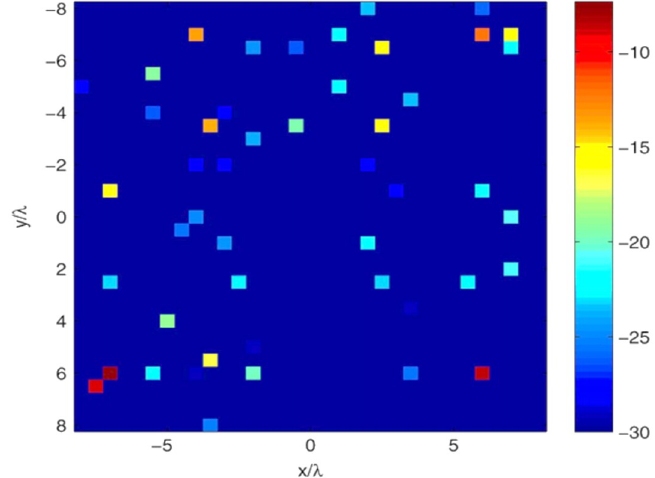
Figure 11. Reconstructed excitation field of reference array employing 30 random noisy measurement points.